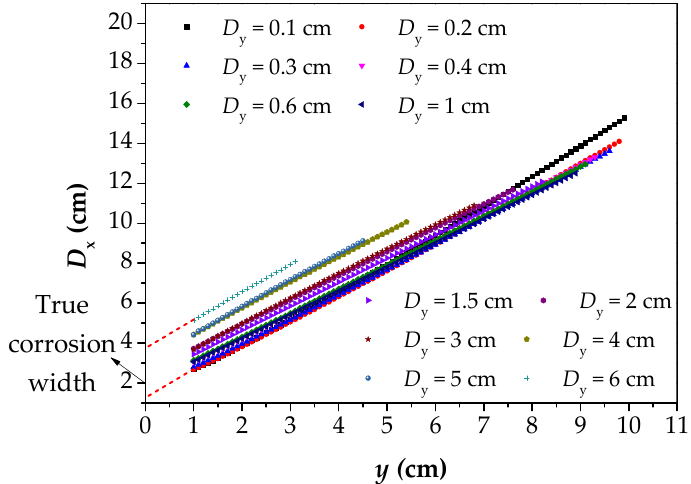
Figure 11. The calculated results of D x with different values of D y . D x : the intersecting point distance between curves of magnetic flux component of x direction at different lift off heights; D y : the difference between two lift off heights; y : the lift off height.